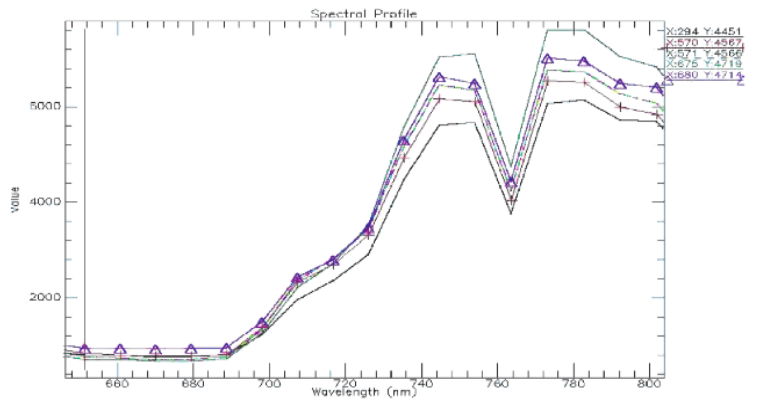
Figure 2: Increasing LAIs of peach tree give higher reflectance values in 740-800 nm range, in